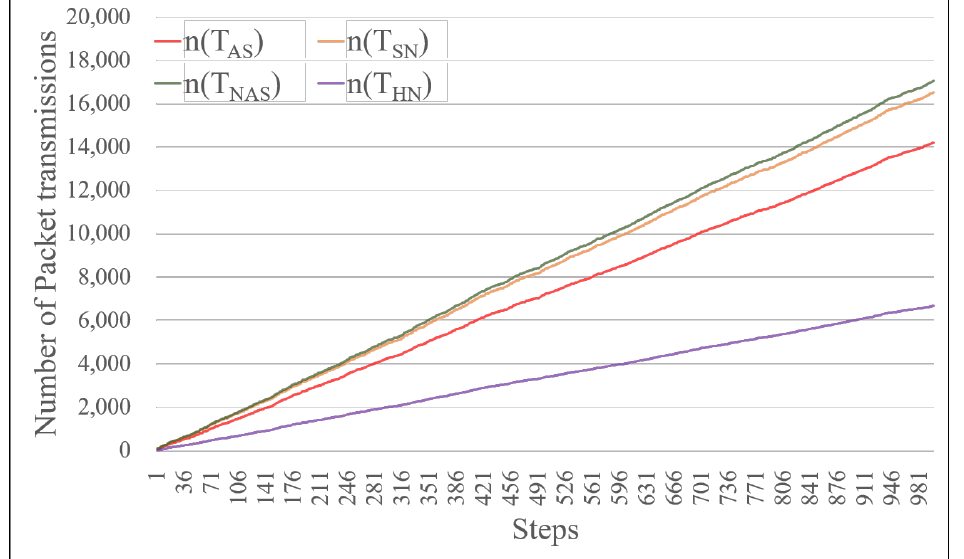
Figure 5. Number of packets generated by the secondary authentication scheme of 3GPP release 15